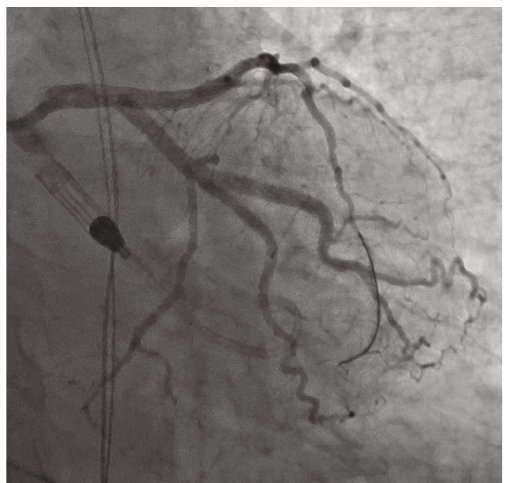
Figure 4: Final angiographic result demonstrating patency of the left coronary system.